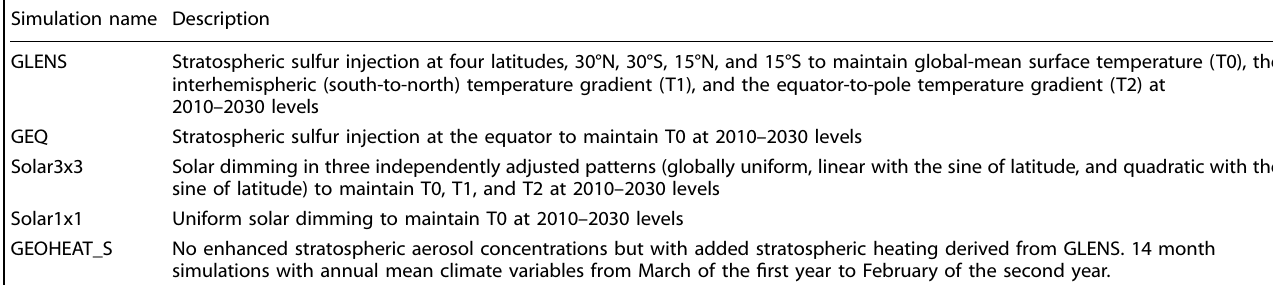
Table 1. Summary of the simulations analyzed in this study, the climate objectives, and the degrees of freedom used 59,60 . Simulation name